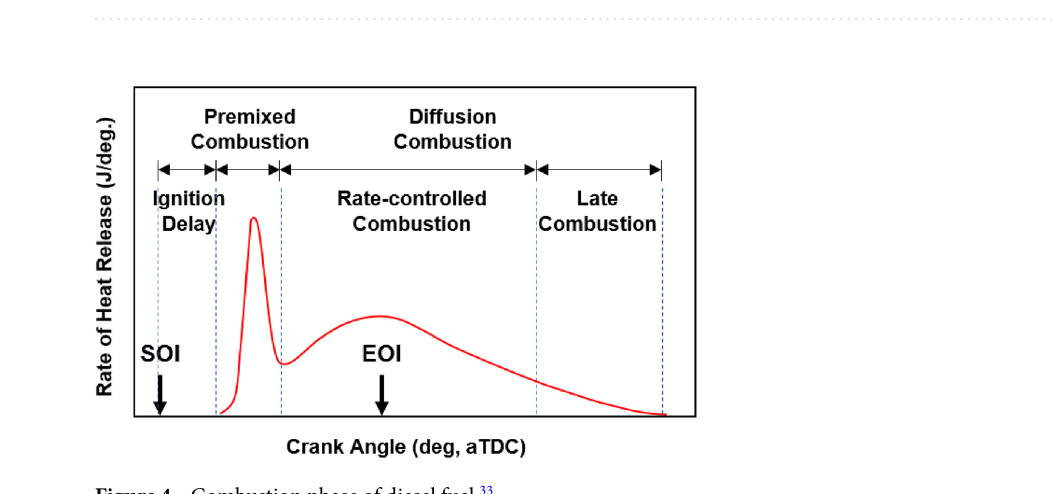
Figure 3. Cylinder pressure and ROHR with respect to the fuel mixture ratio.